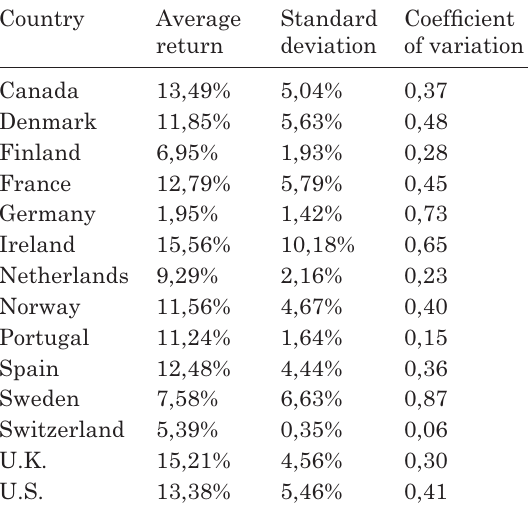
Table 3. Summary statistics of property